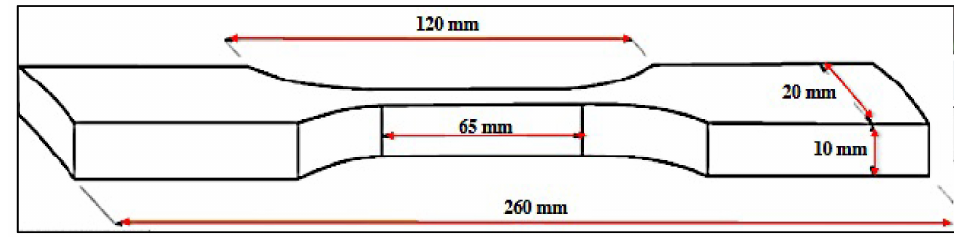
Figure 5. The sample used for the tension test.